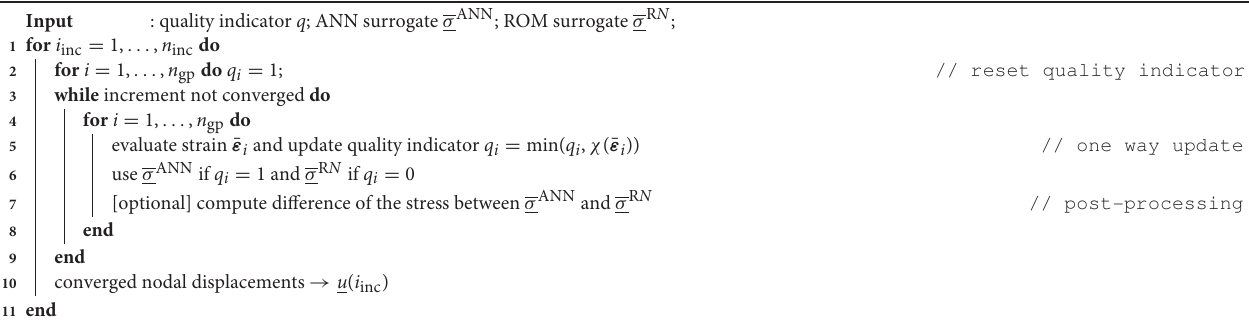
Algorithm 2: Adaptive on-the-fly ANN/ROM twoscale simulation